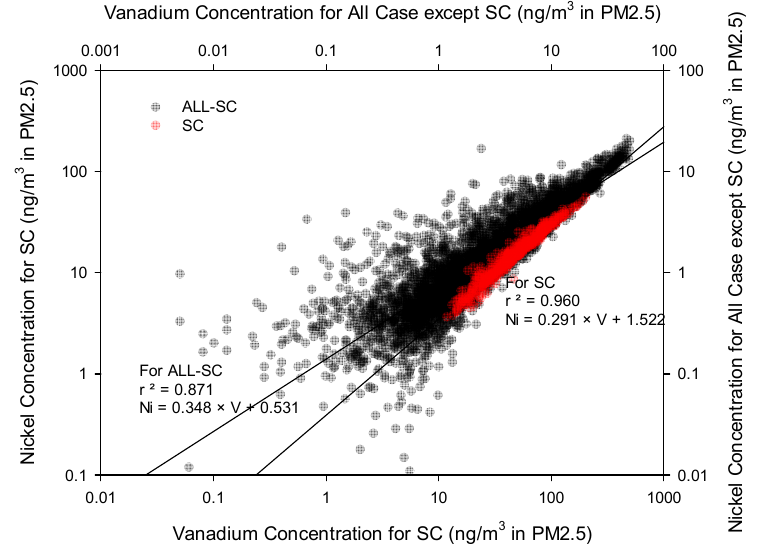
Figure 5. Comparison of vanadium (V) and nickel (Ni) concentrations in the cases excluding selected cases (ALL-SC) and those in the selection cases (SCs).